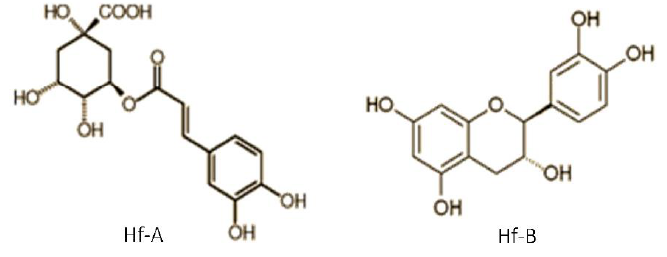
Figure 7. Compounds identified in H. foliosum DCM-MeOH extract; Hf-A chlorogenic acid; Hf-B catechin; Hf-C miquelianin; and Hf-D